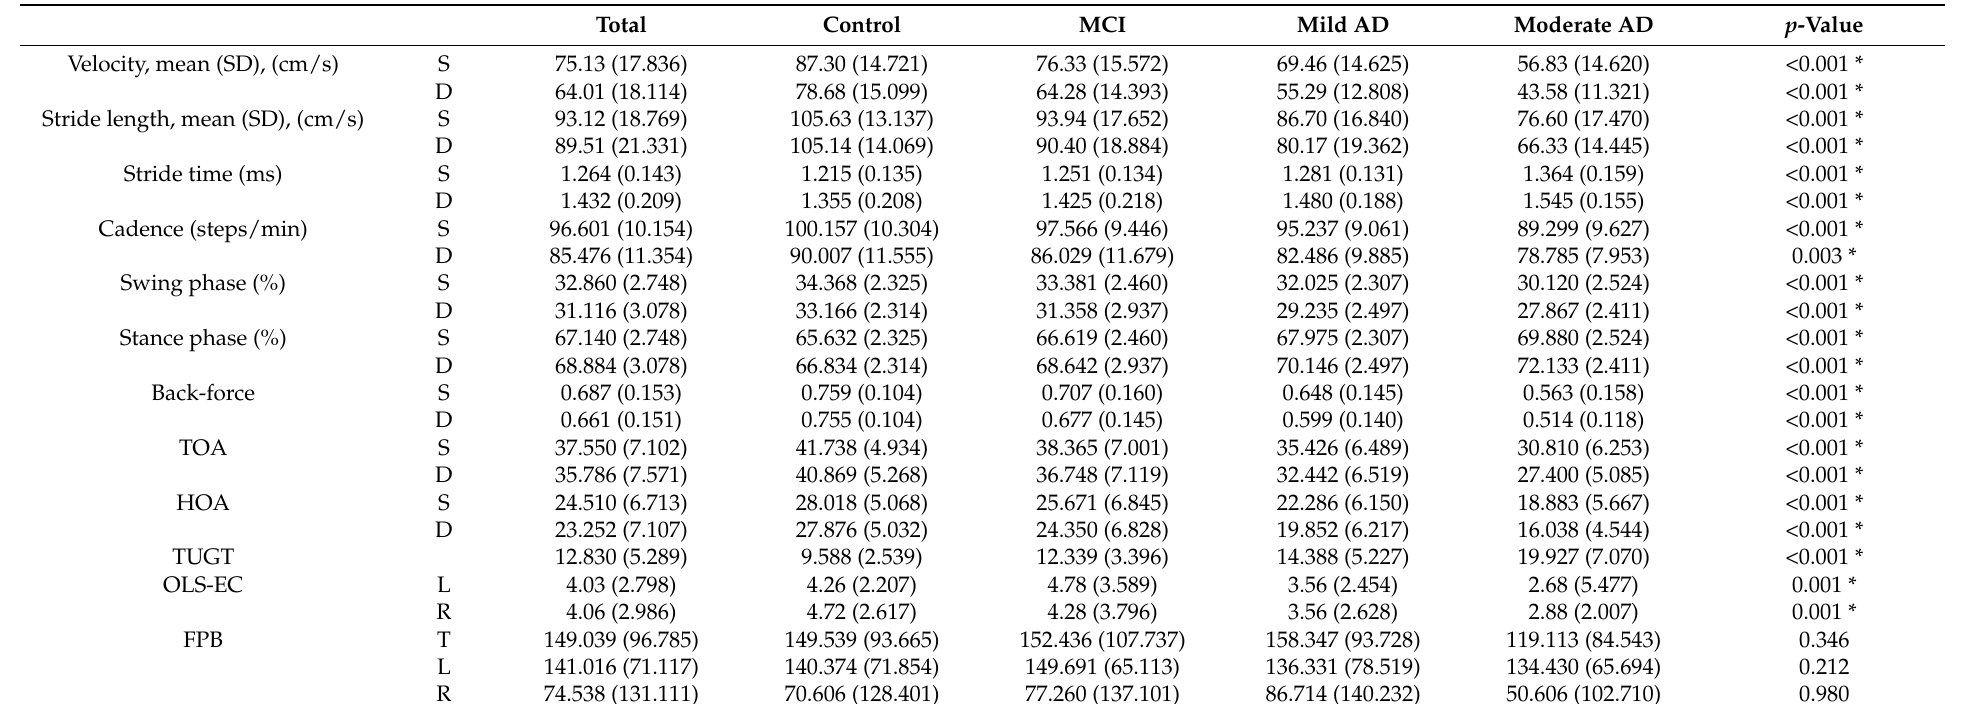
Table 2. Comparison of multiple models of gait data in different individuals with cognitive impairment. Total Control MCI Mild AD Moderate AD p